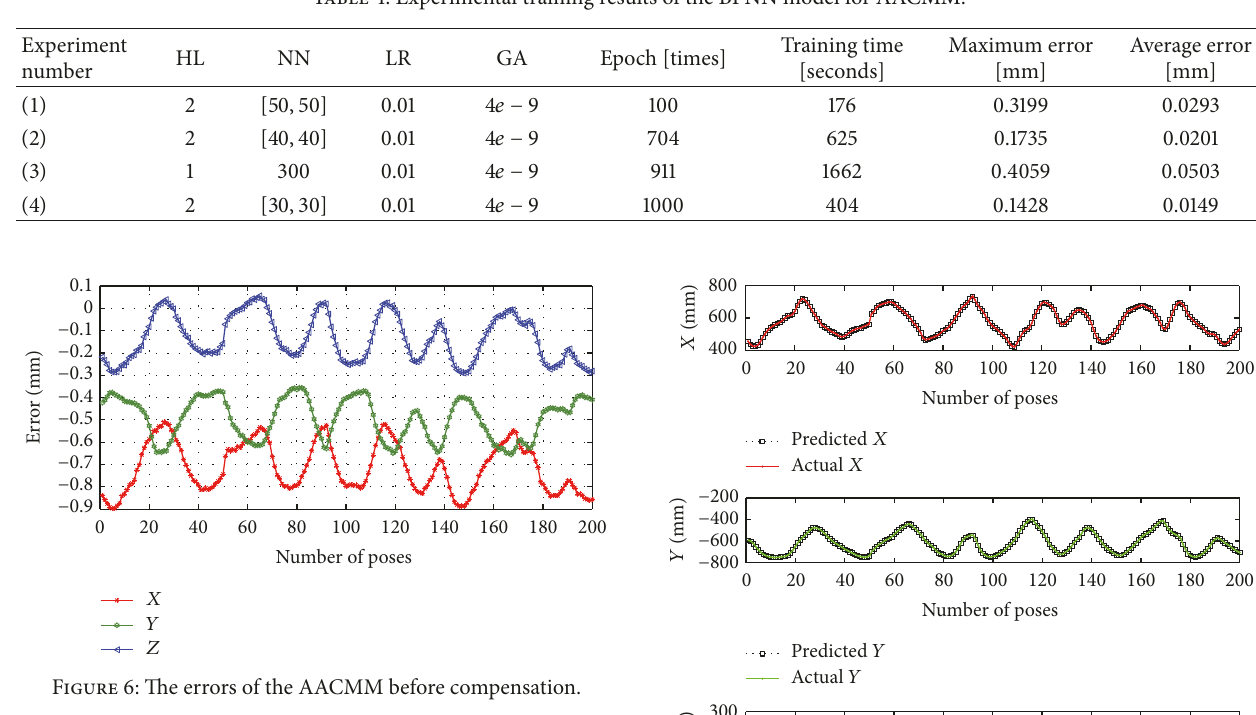
Table 4: Experimental training results of the BPNN model for AACMM.